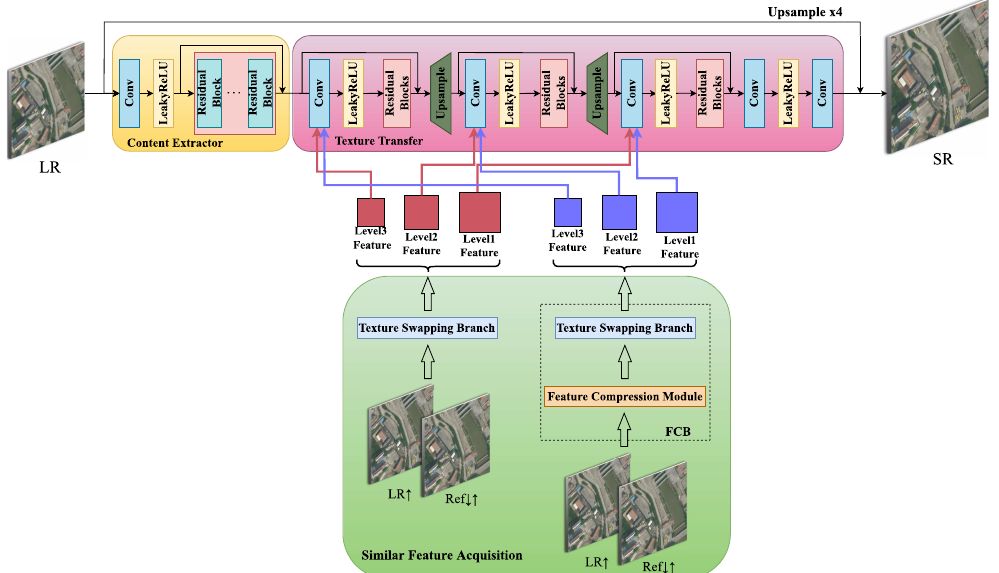
Figure 1. Overall framework of our FCSR method. This consists of three components: content extractor, similar feature acquisition, and texture transfer. Similar feature acquisition provided supplementary information according to the feature premise, and the matching and exchange between the LR and Ref image occurred to ensure texture transfer and reconstruct SR